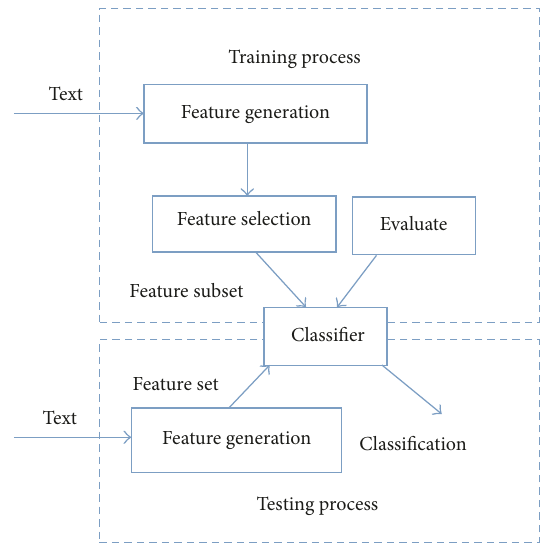
Figure 1: Rumor classification